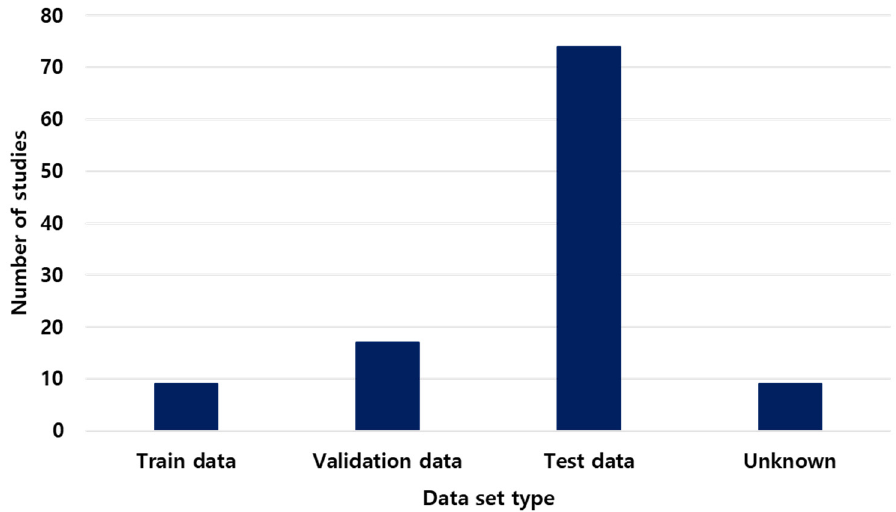
Figure 11. Model evaluation based on the data set type.